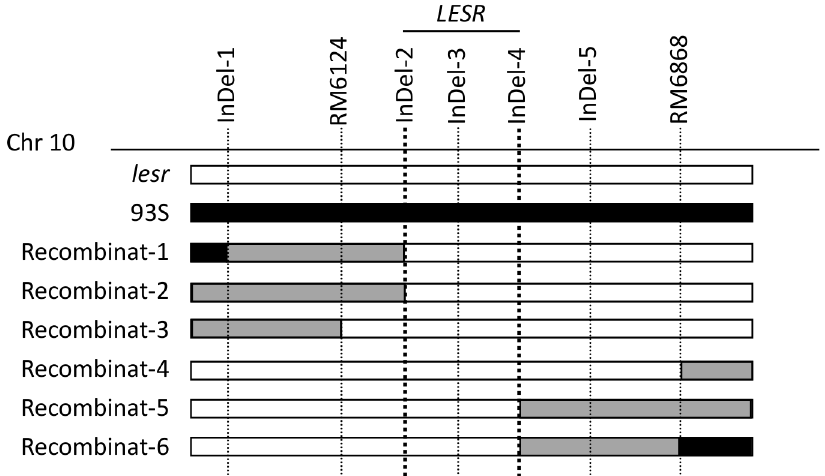
Fig 4. Examination of recombinants in the refined lacation of LESR . The black bar is the doublecrossover plants,the grey bar is the singlecrossoverplants,andthewhite bar is the mutant type plants.Sevenmarkersare localizedon the physicalmap. Six recombinants were detectedin the regiondefinedby the sevenpolymorphic markers.Recombinant-1was from doublecrossoverin the upstreamof InDel-1,andfrom singlecrossover betweenInDel-1and InDel-2;Recombinant-2,Recombinant-3, recombinant-5were from singlecrossover betweenInDel-1and InDel-2,InDel-1and RM6124,InDel-4 and RM6868,respectively; Recombinant-4 was from singlecrossoverin the downstreamof RM6868;Recombinant-6werefrom singlecrossover between InDel-4and RM6868,and from doublecrossover in the downstream of RM6868.Together,these recombinants indicatedthat the LESR locus was locatedwithinan interval of 0.25 Mb on chromosome 10 flankedby InDel-2 (13.69Mb) and InDel-4(13.94Mb).